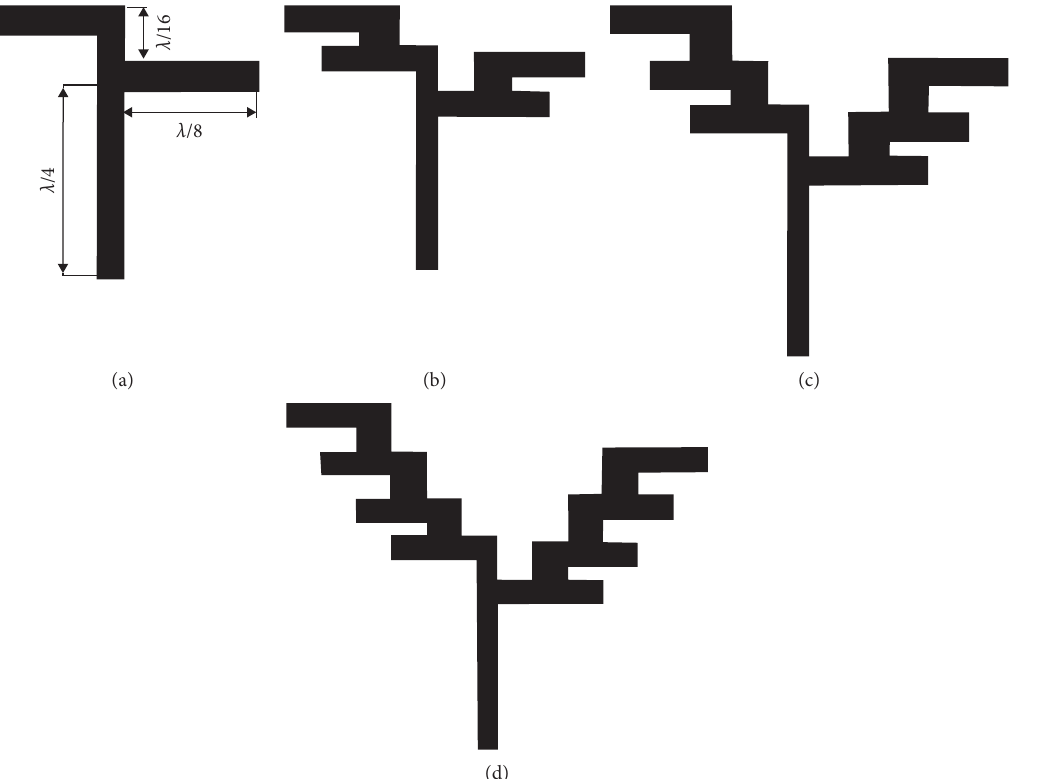
Figure 2: (a) L-shaped monopole; (b), (c), (d) iterations of the inverted L-shaped fractal structure, λ �